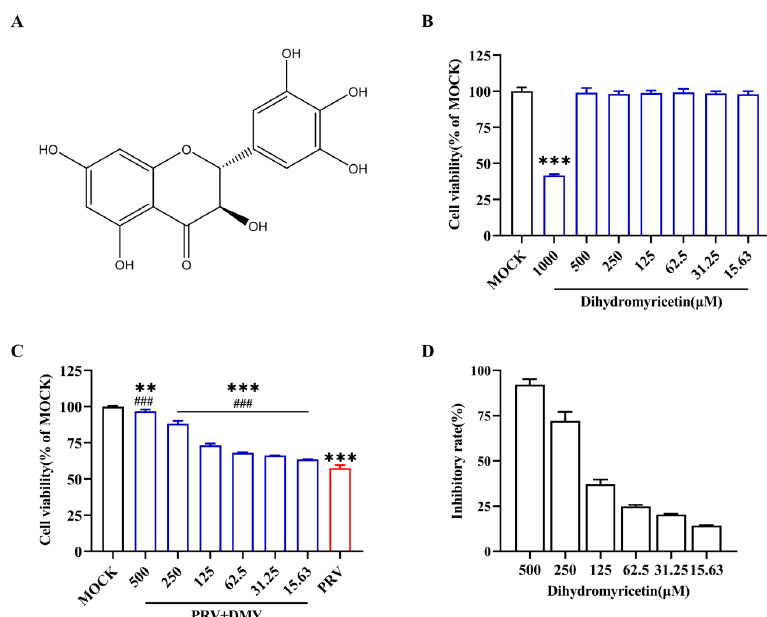
Figure 1. Antiviral activity of dihydromyricetin against PRV. ( A ) The constructive formula of dihy- dromyricetin (DMY). ( B ) Toxicity of DMY on PK-15 cells. Two-fold dilutions of DMY (1000 -15.63 μM) were incubated with PK-15 cells, and a CCK-8 kit was utilized to assess cell viability after in- cubation for 48 h. ( C ) Cell viability after infection with PRV. The PK-15 monolayer was subjected to 100 TCID 50 PRV in conjunction with DMY for 1 h before being switched to a maintenance medium containing DMY. Once more, the CCK-8 kit was used to conduct the test after 48 h. ( D ) DMY’s resistance to PRV inhibition rate. Inhibition rate = (OD 450 nm value of DMY-treated infected cells— OD 450 nm value of untreated infected cells) ÷ (OD 450 nm value of untreated uninfected cells—OD 450 nm value of untreated infected cells). Mock, normal cell groups; PRV, virus-inoculated group; PRV + DMY, virus-inoculated and treated group. ### indicates p < 0.001 compared to PRV group; *** indicates p < 0.001 compared to MOCK group. Table 1. Primer sequences for real-time PCR. Primer